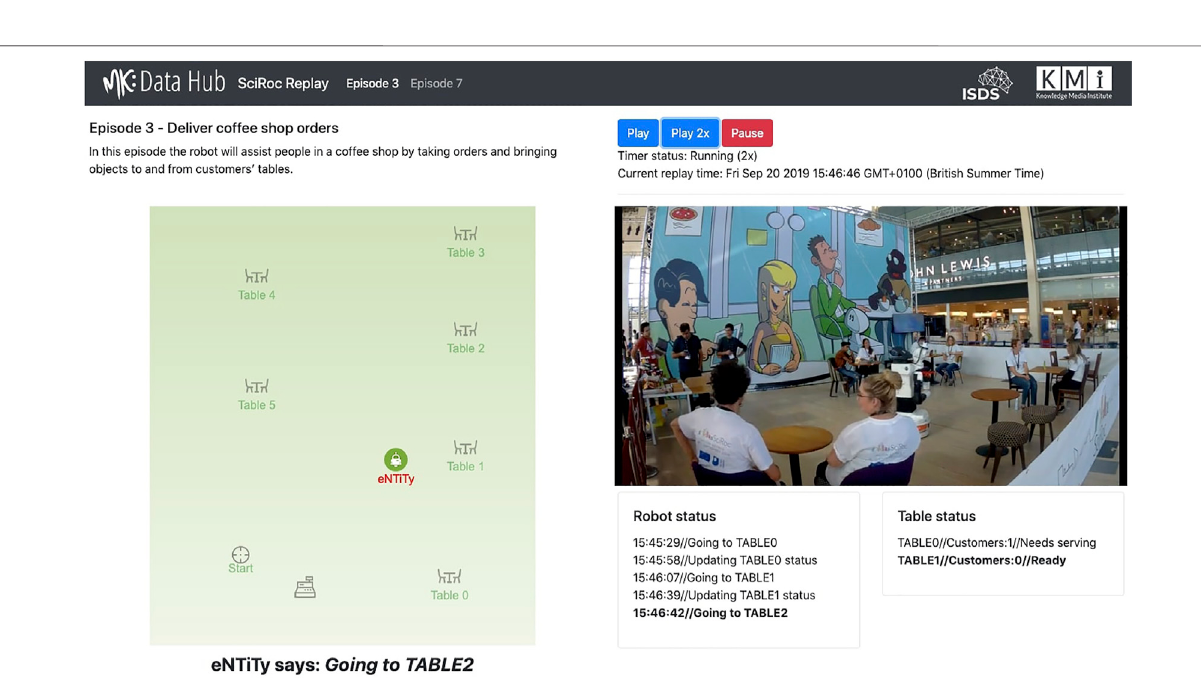
Frontiers in Robotics and AI |